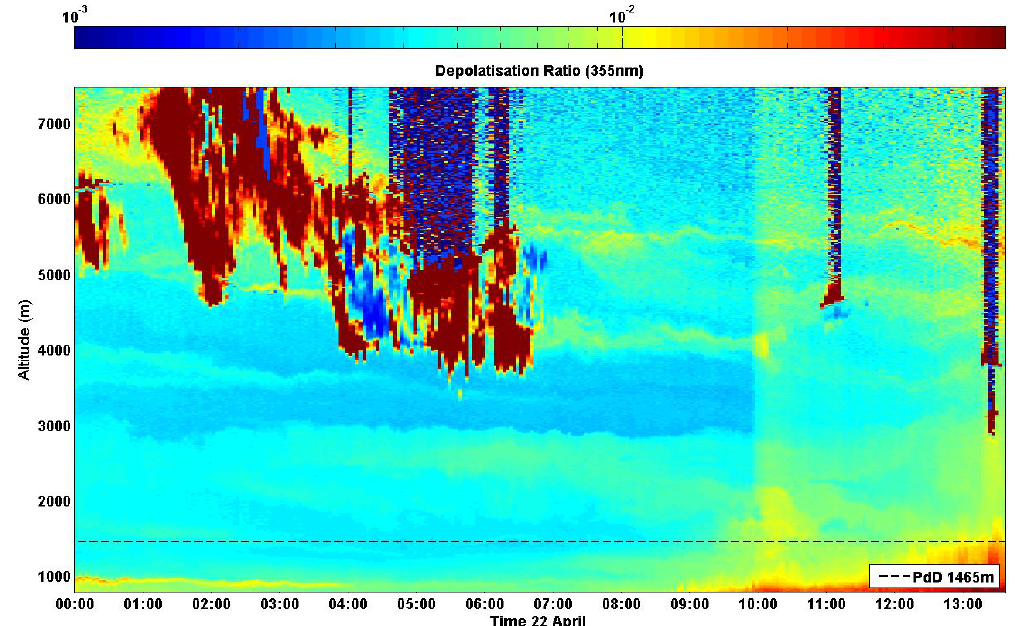
Fig. 10. Lidar volume depolarisation ratio on 22 April 00:00 to 13:30UTC.